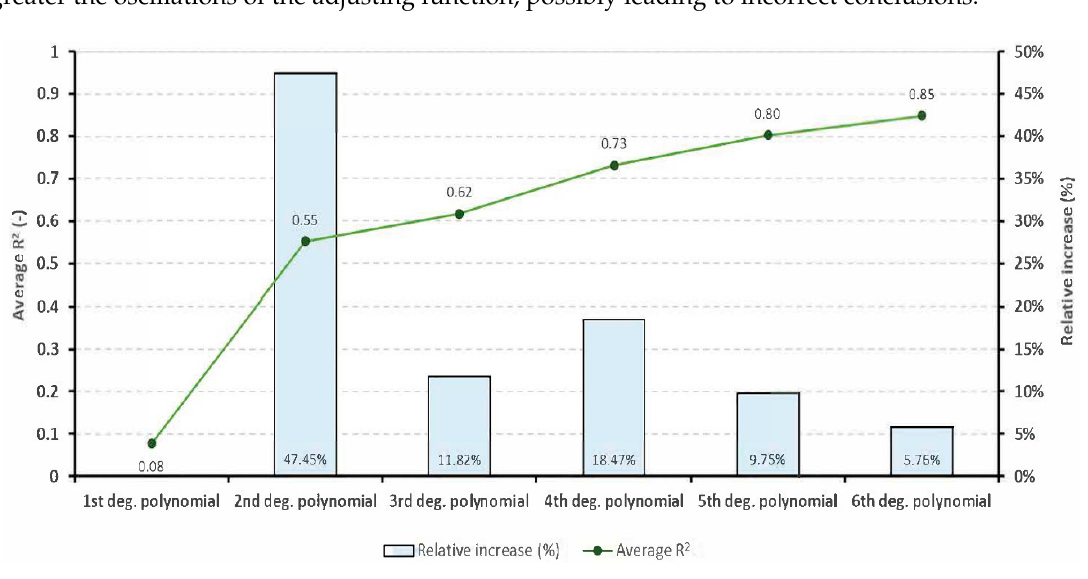
Figure 3. Average statistic estimator R 2 value for each adjustment polynomic function.